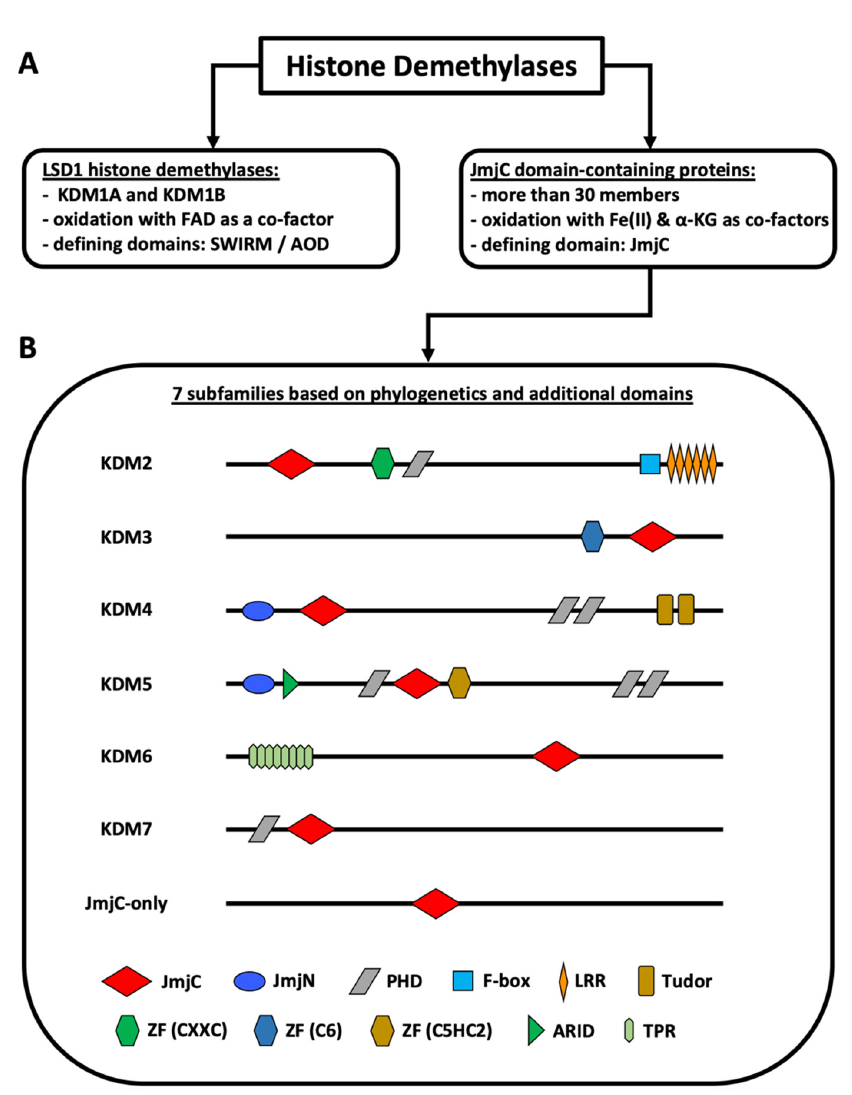
Figure 1. Classification of histone demethylases. ( A ) Types of histone demethylases. ( B ) Subfamilies of JmjC domain-containing proteins. The KDM2–7 subfamilies are known histone demethylases. The JmjC-only subfamily contains demethylases, hydroxylases, and proteins with unknown functions. KDM4D+E lack the PHD and the Tudor domains. KDM5C+D only possess one C-terminal PHD domain. KDM6B lacks the TPR domains. The figure is based on Klose et al. [1], Chen et al. [6], Franci et al. [7], Markolovic et al. [8], and Chang et al. [9]. Abbreviations: α KG (alpha-ketoglutarate), AOD (amino oxidase domain), ARID (AT-rich interaction domain) domain, FAD (flavin adenine dinucleotide), JmjC (Jumonji C) domain, JmjN (Jumonji N) domain, LRR (leucine-rich repeat) domain, PHD (plant homeodomain) domain, TPR (tetratricopeptide repeat domain), ZF (zinc finger) domain.